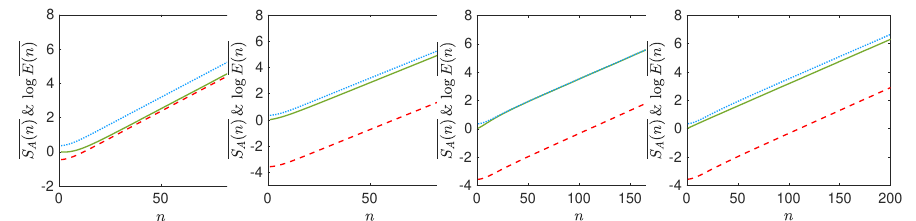
( n )) (green solid lines) Figure 15: Averaged entanglement entropy evolution 3 (cid:69) ( S A || ) and the total energy evolution 1 log (cid:69) ( E ( n )) (red dashed lines), and (cid:69) ( log || Π n 2 (blue dotted lines) at sub-type 1, 3, 4, and 5 exceptional points (from left to right). The subsystem A is chosen as [( k − 1 / 2 ) l , ( k + 1 / 2 ) l ] where k ∈ (cid:90) . The slopes of the